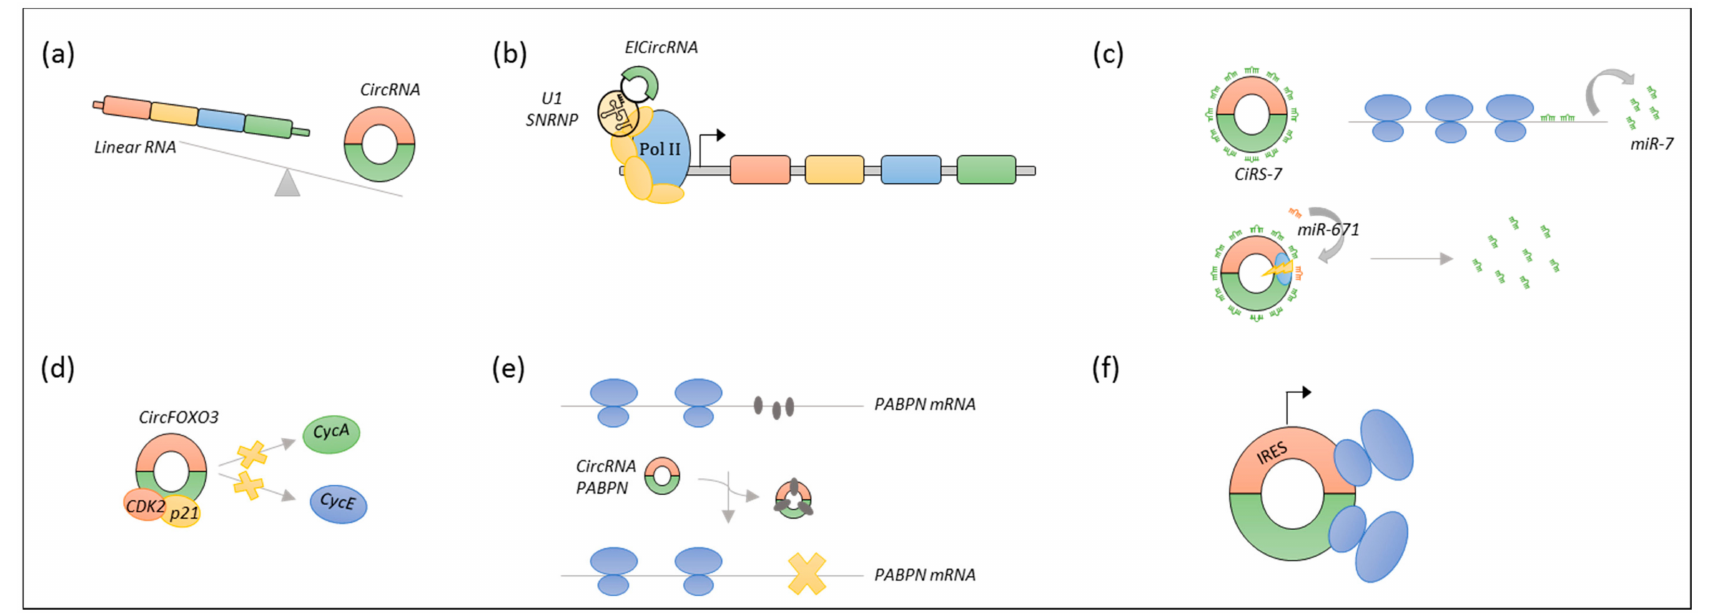
Figure 3. Proposed functions of circular RNAs (circRNAs). ( a ) CircRNAs can regulate gene expression indirectly through competition with canonical splicing. ( b ) Exon-intron circular RNAs (EICircRNAs) can directly enhance the transcription of host genes through interaction with the transcription complex. ( c ) CircRNAs can function as microRNA (miRNA) sponges, here exemplified by circular sponge for miR-7 (ciRS-7), which has >70 binding sites for miR-7. In the presence of ciRS-7, miR-7 target mRNA will be released from the miRNA-mediated repression. Upon binding of miR-671, an argonaute 2 (AGO2)-mediated cleavage occurs, providing immediate activation of miR-7 ( d ) CircRNAs can function as protein scaffolds or decoys. CircFOXO3 forms a ternary complex with p21 and cyclin-dependent kinase 2 (CDK2), blocking the interaction with cyclin A and cyclin E, thereby retarding cell cycle entry. ( e ) CircRNAs can serve as specific or global regulators of protein translation. CircRNA polyadenylate-binding protein nuclear (PABPN) sequesters the RNA-binding protein Hu Antigen R (HuR), leading to decreased PABPN mRNA translation. ( f ) Under certain circumstances, circRNAs have been reported to be